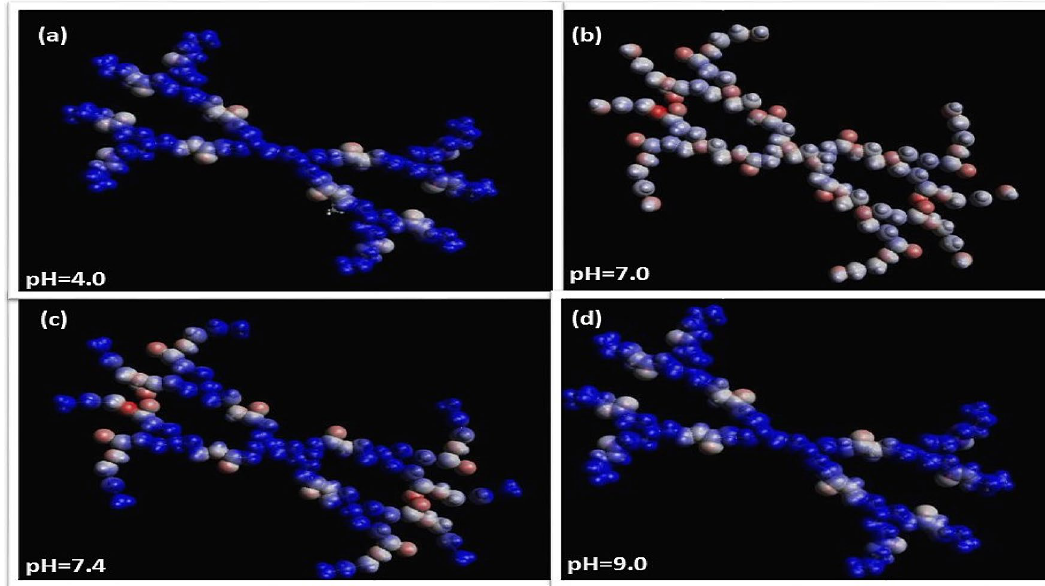
Figure 4. Comparison of Van der Walls effect on 1.0G polyamidoamine generation at ( a ) pH = 4.0, ( b ) pH = 7.0, ( c ) pH = 7.4 and ( d ) pH = 9.0 (Blue region: Van der Waals sphere; Other region: Electrostatic potential) (Avogadro 1.1.1, http://avoga dro.cc).